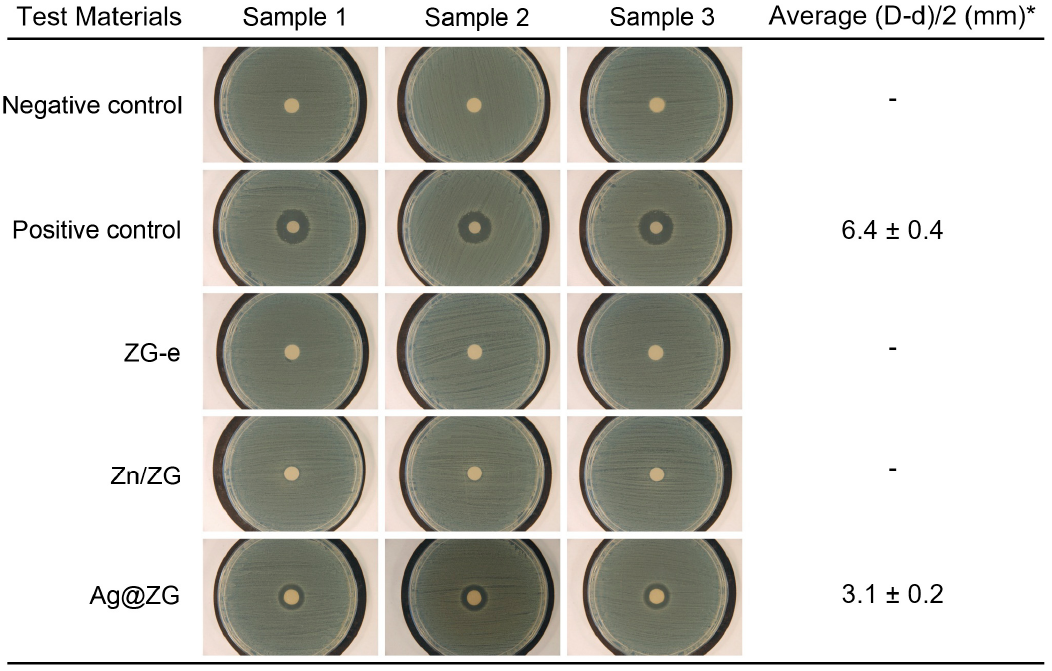
Figure 6. Agar di ff usion assay: photos of the inhibition halos generated by the di ff erent treatments. These photos refer to one of the three independent experiments performed and are representative of the overall observations. Negative Control: untreated paper disk; Positive Control: paper disk loaded with 50 U penicillin and 0.05 mg streptomycin; ZG-e: ZG-e loaded paper disk; Zn / ZG: Zn / ZG loaded